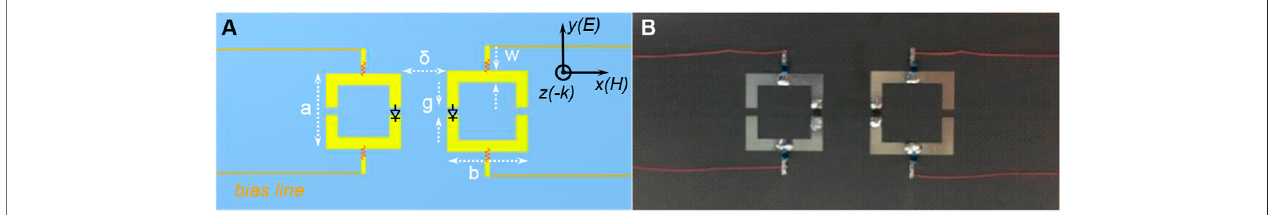
FIGURE1| Frontviewofthefrequency-agileFano-resonantmetasurface.Schematicdiagram (A) andphotograph (B) ofthefabricatedsample.Themetasurfaceis composed of a pair of asymmetric split ring resonators (ASRRs) on a Te fl on substrate. Double varactor diodes are soldered in the middle gap of the asymmetric rings. Four inductors and four bias copper wires are integrated into the metasurface. The geometric parameters are: a (cid:2) 13 mm, b (cid:2) 14 mm, w (cid:2) 2 mm, g (cid:2) 1.3 mm, and δ (cid:2) 8 mm.